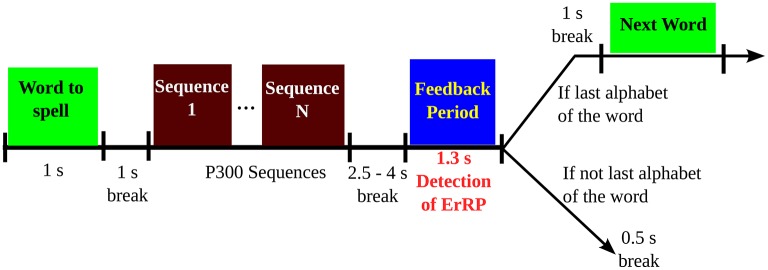
Sequence of a trial in the P300-speller task, as given in Perrin et al. (2012). The feedback period is the period of interest in this study.